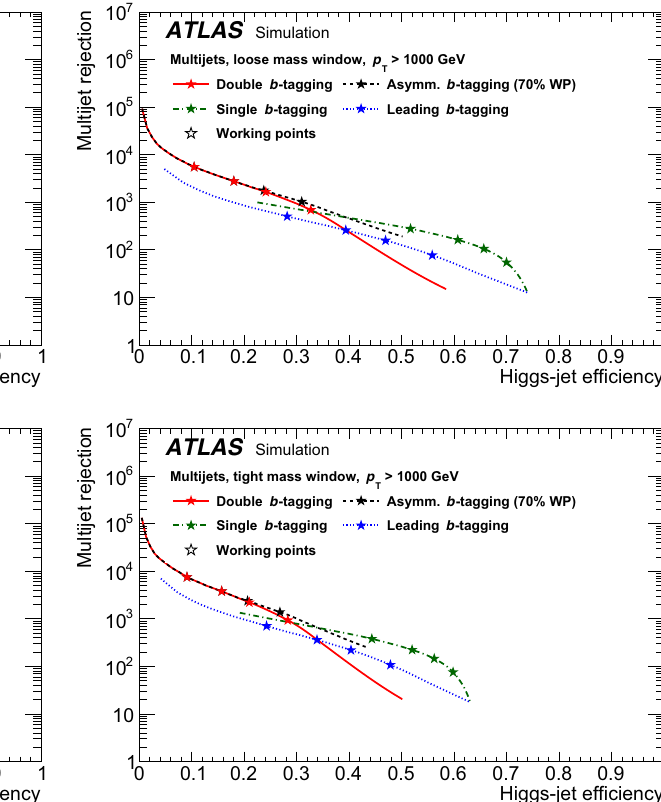
Fig. 8 Rejection of multijet background as a function of the Higgs boson tagging efficiency for loose (top) and tight (bottom) mass win- dow requirements for large- R jet p T above 250 GeV (left) and above 1000 GeV (right) for various b -tagging benchmarks. The stars corre-